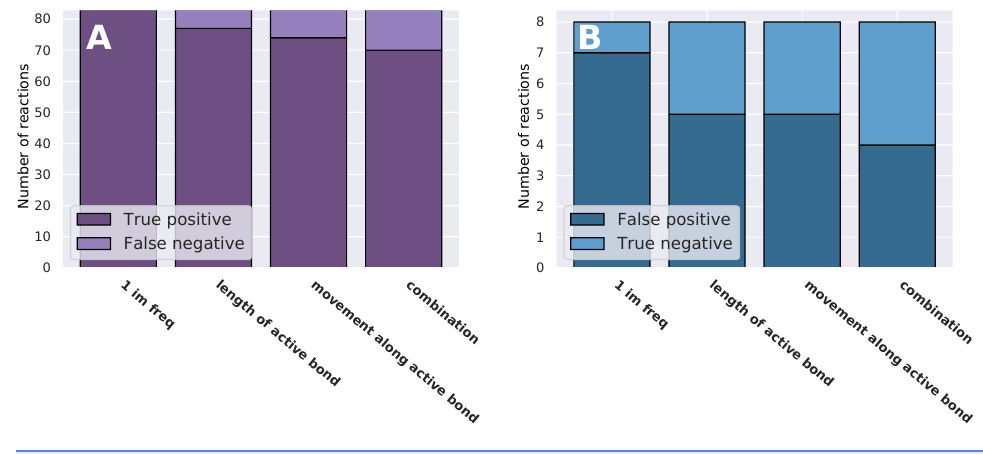
Figure 8 Test of different TS validation methods for the (A) True TSs; and (B) wrong TSs of run 1. Full-size DOI: